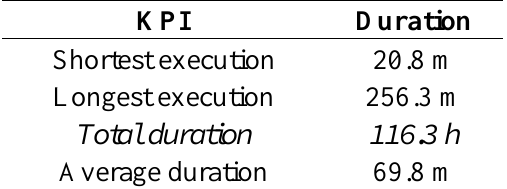
Table 10. KPIs, by using single-valued parameters, for 100